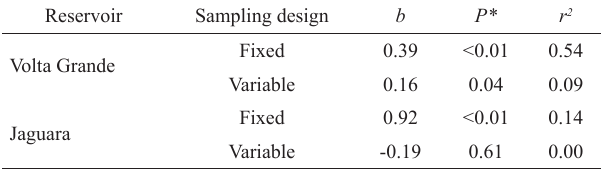
Fig 4. Frequency distribution by standard length (SL) class of curimba for fixed and variable sampling sites in Volta Grande (VGR) and Jaguara (JR) reservoirs. Tab. 2. Coefficients of regression ( b ) and determination ( r 2 ) of the regression for standard length of curimba by distance of capture per reservoir and sampling design.